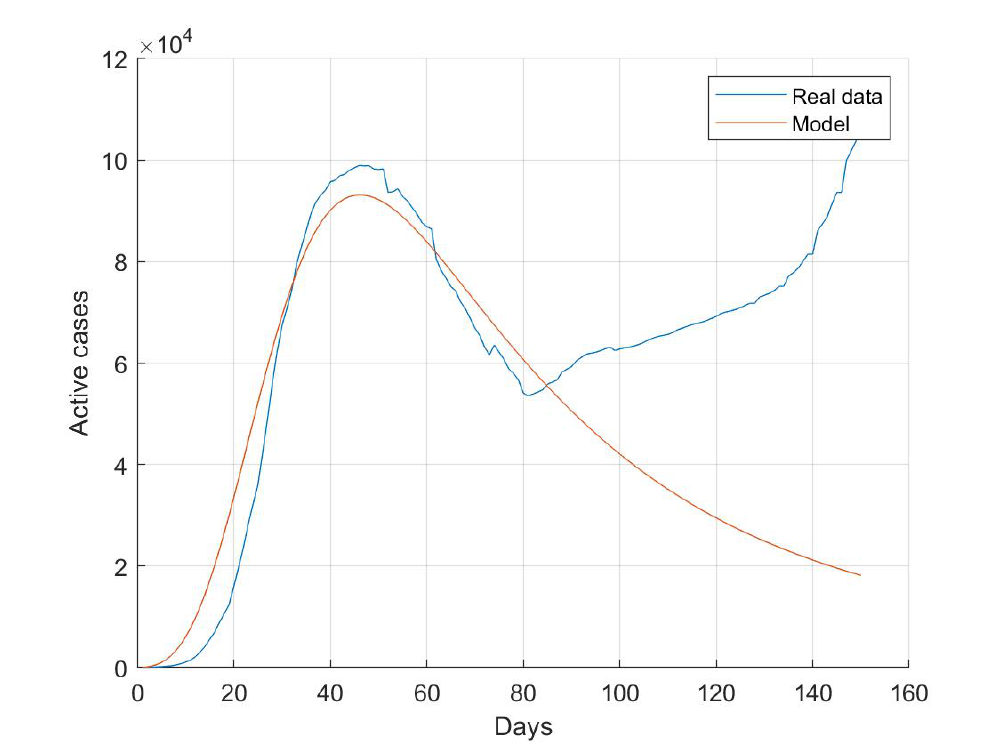
Figure 5. Modeled vs. actual disease transmission in